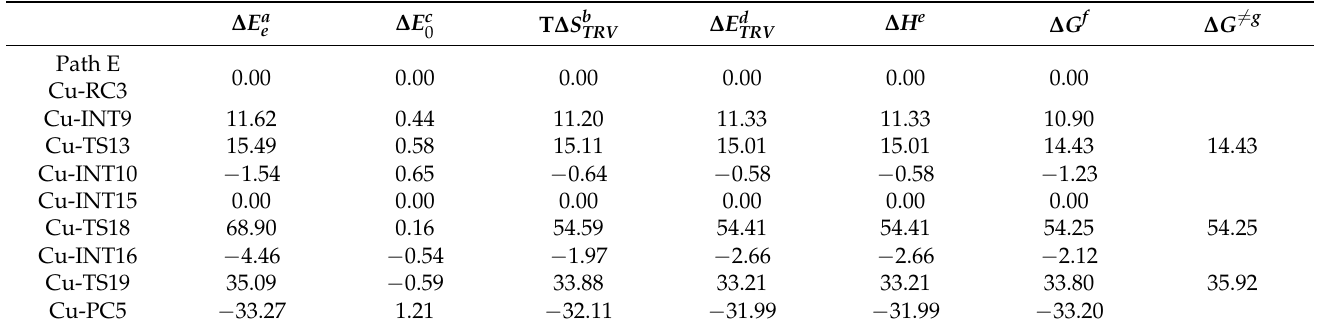
Table 5. Relative energies (in kcal/mol) with respect to the reactant complex (RC) for the catalytic hydrolysis of HCN with Cu-ZSM-5 in the gas phase of path E at the B3LYP/6–31++G (d,p)